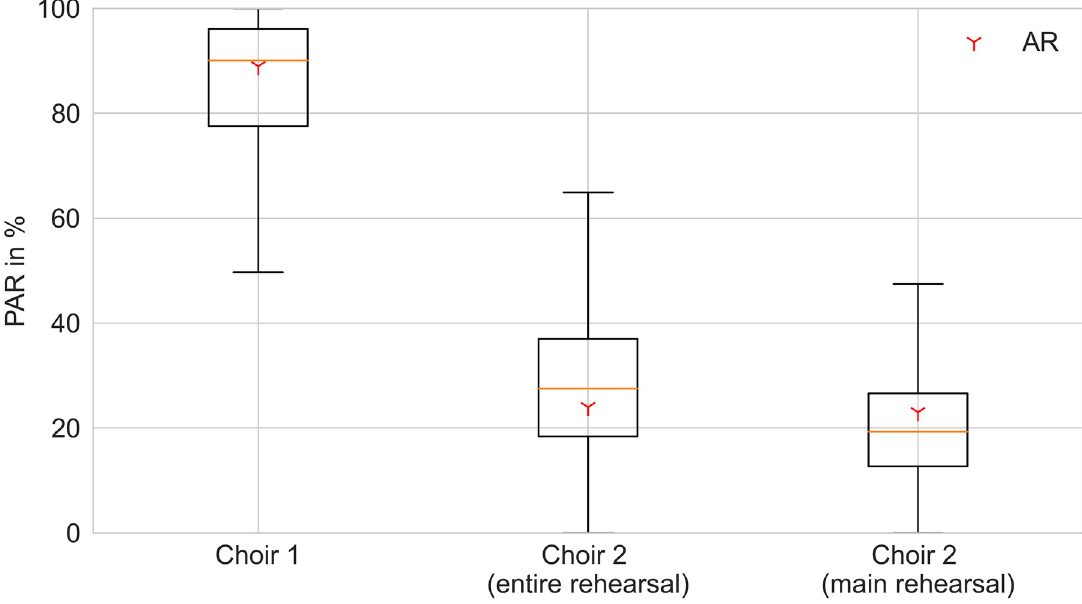
Fig 8. Predicted Attack Rate (PAR) for the two rehearsals from the PAR model [10], Berlin, March 2020. The error bars indicate the uncertainty resulting from parameter estimation, the red three-pointed stars indicate the observed attack rates